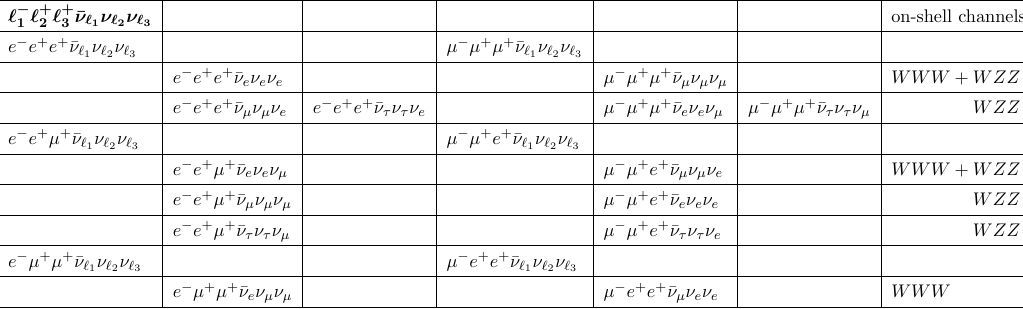
Table 1 . Break-up of the contributing leptonic channels to trilepton production.